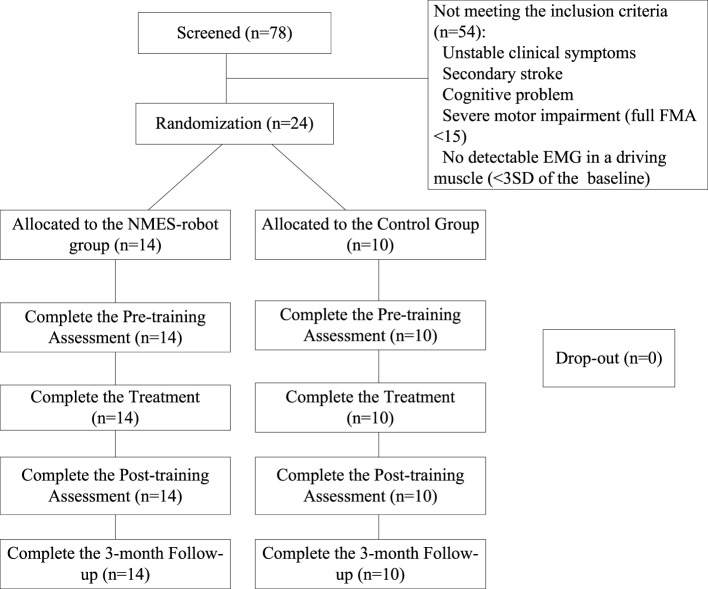
The Consolidated Standards of Reporting Trials flowchart of the experimental design.